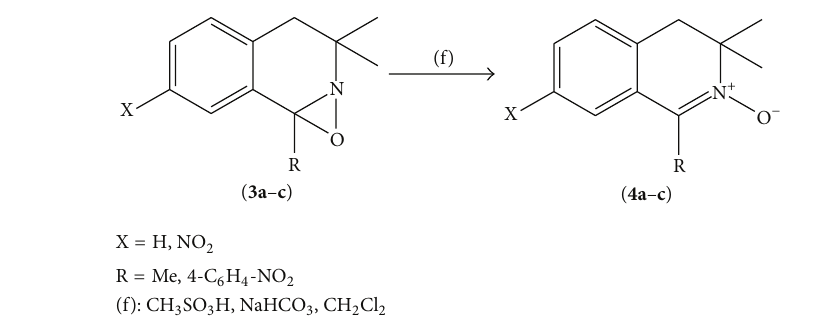
Scheme 2: Oxaziridine 3c under the action of acid.